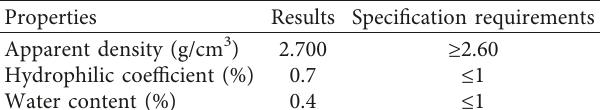
Table 4: Properties of mineral filler.